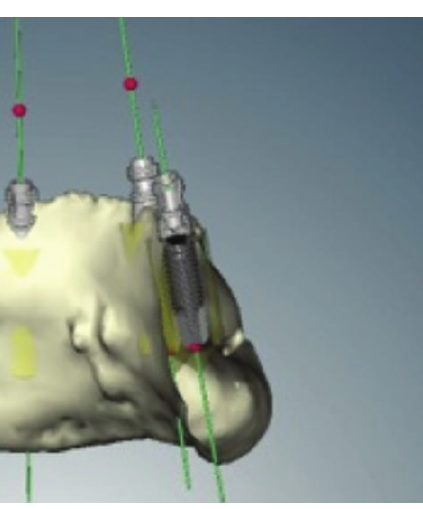
Figure 13: The yellow shade representing the safety area.